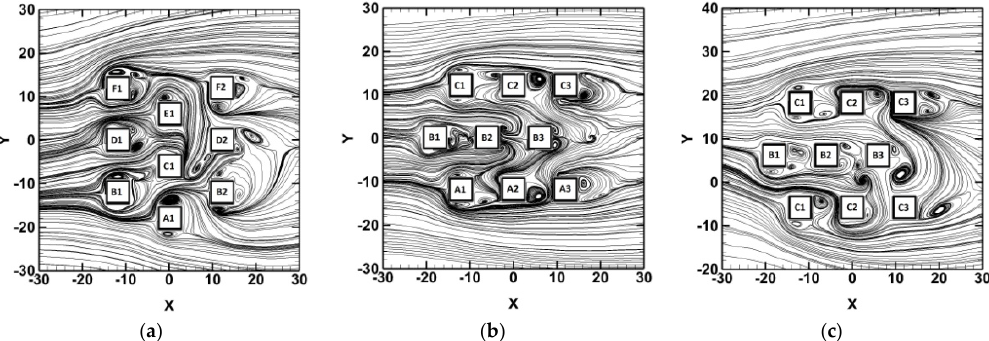
Figure 4. Time-averaged streamlines of the horizontal plane Z = 1 m for ( a ) Case 1; ( b ) Case 2; ( c ) Case 3. Figure 5a–c present the time-average streamlines for the fire symmetry plane at Y = 0 m for the